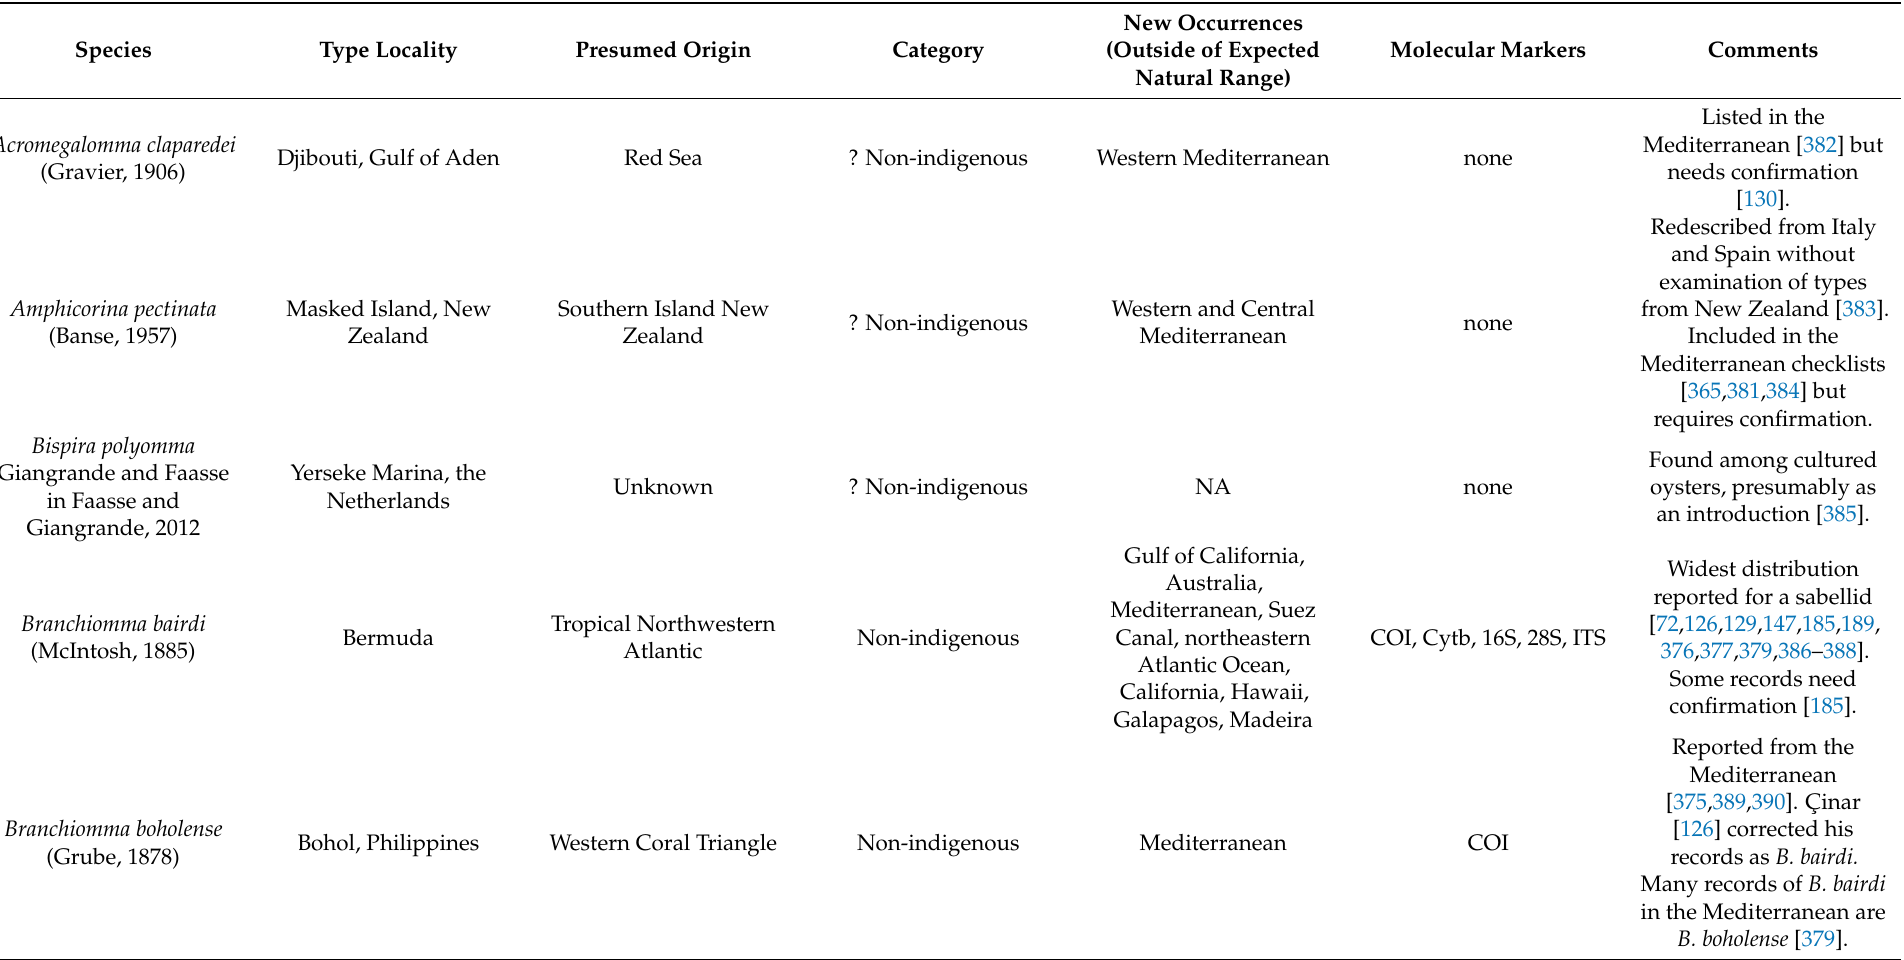
Table 6. List of translocated species, with presumned origin indicated by provinces or ecoregions ( sensu Spalding et al. [31]). Those species that are included as unresolved, require confirmation and two are not cosmopolitan ( Branchiomma curtum and Parasabella pallida ). NA: not